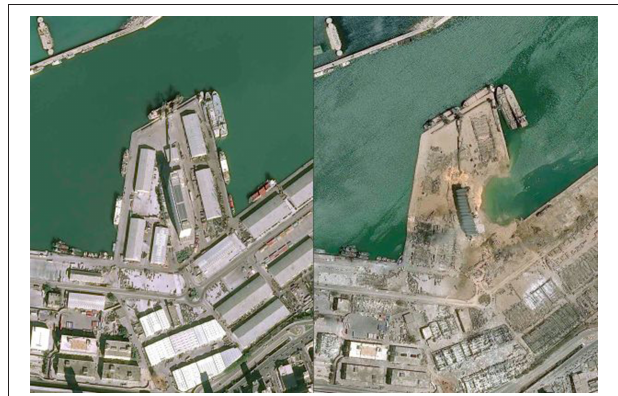
FIGURE 3 | Satellite picture for the Beirut explosion (before and after).